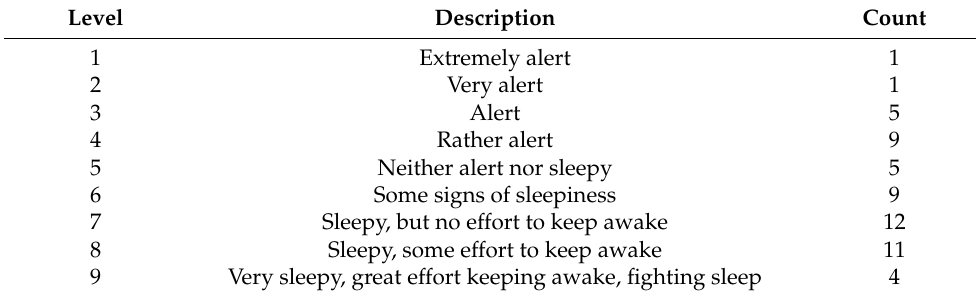
Table 3. Karolinska Sleepiness Scale